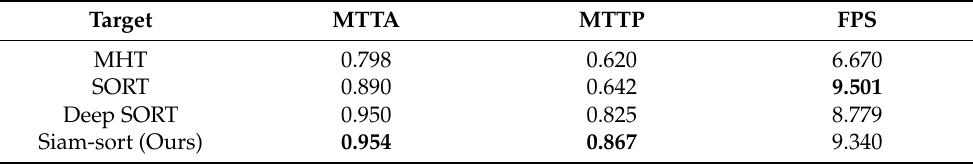
Figure 23. The comparison results of Siam-sort with other methods for the second test set. Table 6. The comparative results of four methods on the three overall